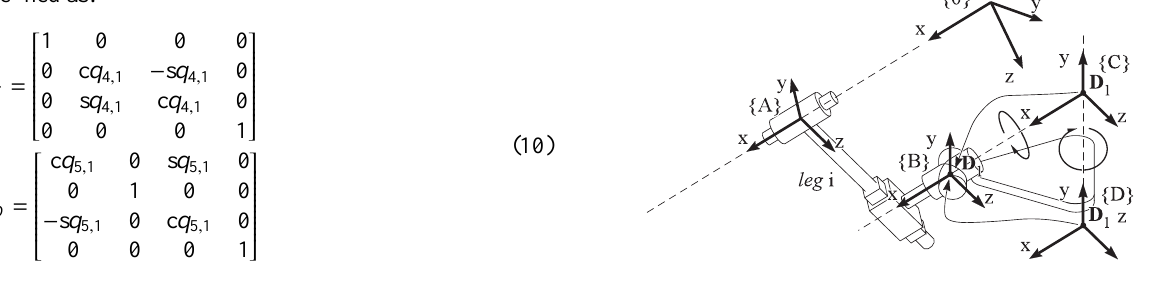
Figure 3. Local frames used for definition of joints unit